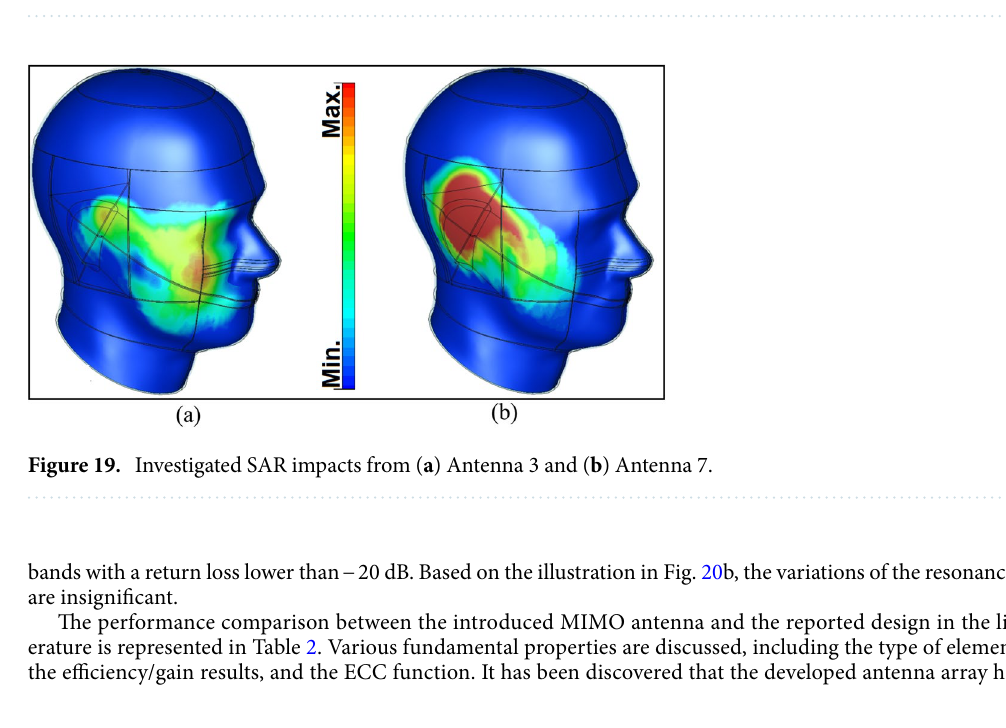
Figure 18. ( a ) Placement of the antenna and ( b ) the achieved efficiencies.